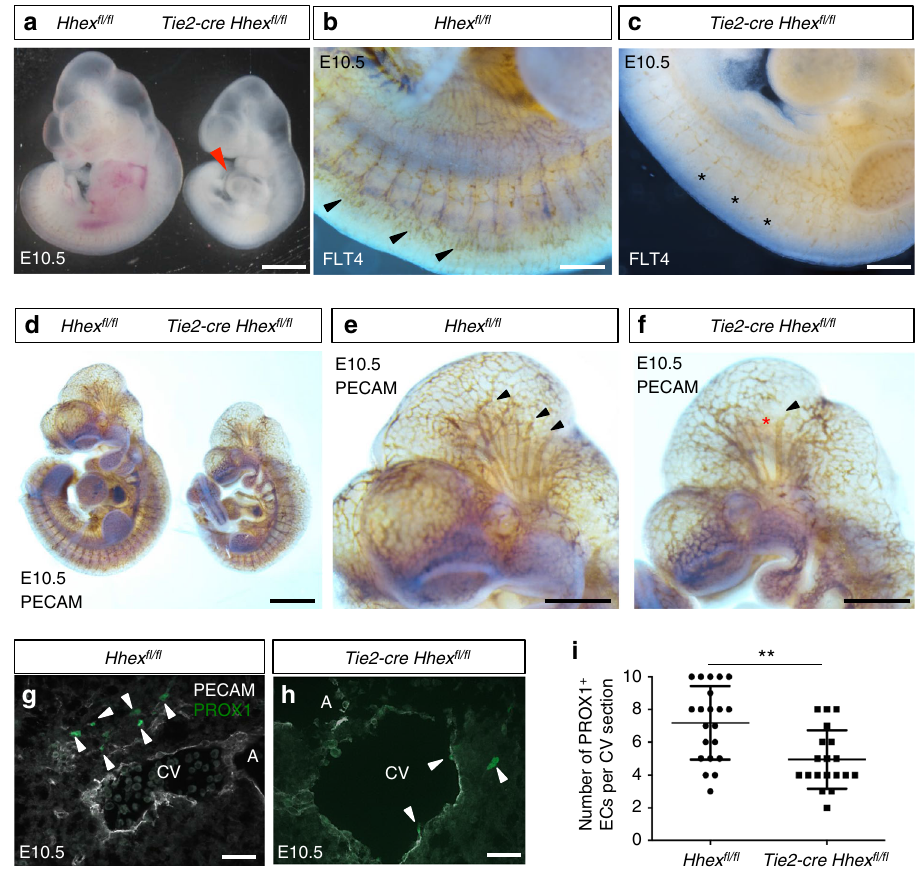
Fig. 6 Tie2-cre Hhex fl / fl mouse embryos exhibit minor vascular defects and a reduced number of PROX1 + endothelial cells at E10.5. a Whole-mount view of Hhex fl / fl and Tie2-cre Hhex fl / fl embryos at E10.5. Hhex mutants exhibit pericardial edema (red arrowhead) as well as developmental delay. b , c Whole-mount views of Hhex fl / fl and Tie2-cre Hhex fl / fl embryos at E10.5 after FLT4 immunostaining. Hhex mutants exhibit a strong decrease in FLT4 expression in the intersomitic vessels (arrowheads point to intersomitic vessels; asterisks indicate reduction of FLT4 expression in the same structures). d – f Whole-mount view of Hhex fl / fl and Tie2-cre Hhex fl / fl embryos at E10.5 after PECAM immunostaining. Hhex mutants exhibit minor vascular defects in the head (arrowheads point to blood vessels in Hhex fl / fl and Tie2-cre Hhex fl / fl ; asterisk indicates lack of vessels in the same structures in Tie2-cre Hhex fl / fl ). g , h Maximum intensity projections of confocal images from transverse cryosections of Hhex fl / fl and Tie2-cre Hhex fl / fl E10.5 embryos after immunostaining for PECAM (white) and PROX1 (green) in the cardinal vein (CV) and aorta (A) region. Hhex mutants exhibit fewer PROX1 + /PECAM + endothelial cells in the region of the CV (arrowheads point to PROX1 + /PECAM + endothelial cells). i Quanti fi cation of the number of PROX1 + endothelial cells in the CV region in Hhex fl / fl ( n = 2) and Tie2-cre Hhex fl / fl ( n = 2) embryos. Values represent means ± s.e.m. ** P ≤ 0.01 by t -test. Scale bars: 1 mm ( a , d ), 200 μ m ( b , c ), 500 μ m ( e , f ), and 20 μ m ( g , h